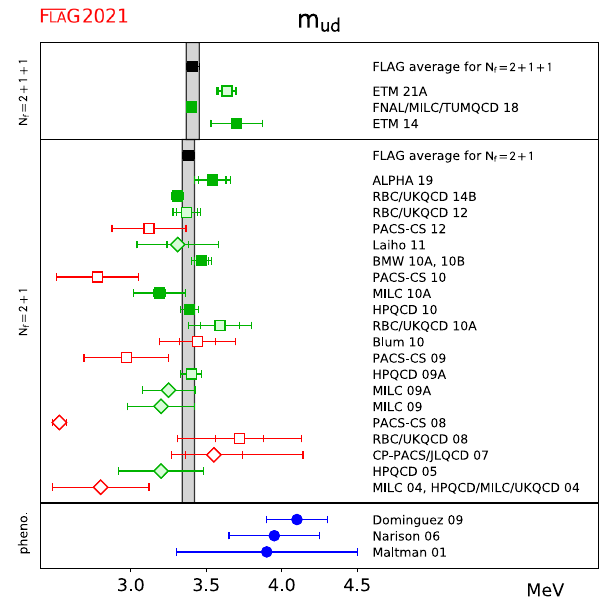
( m + m ) . The bottom panel shows results based on sum rules [205,208,210] (for more u d 2